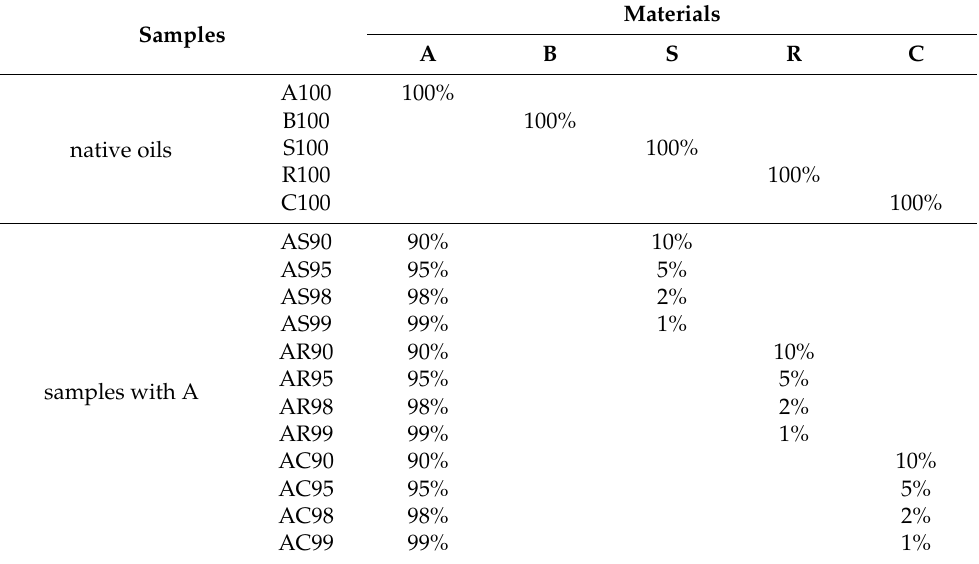
Table 2. Sample preparation and labelling for the spectroscopic analysis. A and B are the two Mexican chia oils, S is sunflower oil, R is rapeseed oil and C is corn oil. All values are mass